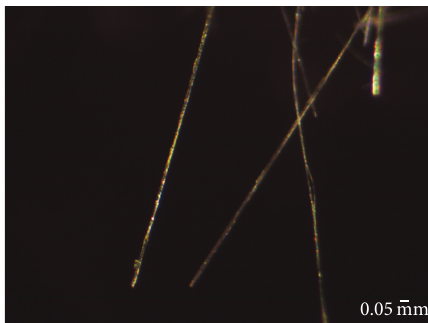
Figure 7: Comparison of the dry bulk density between the series and the reference sample.